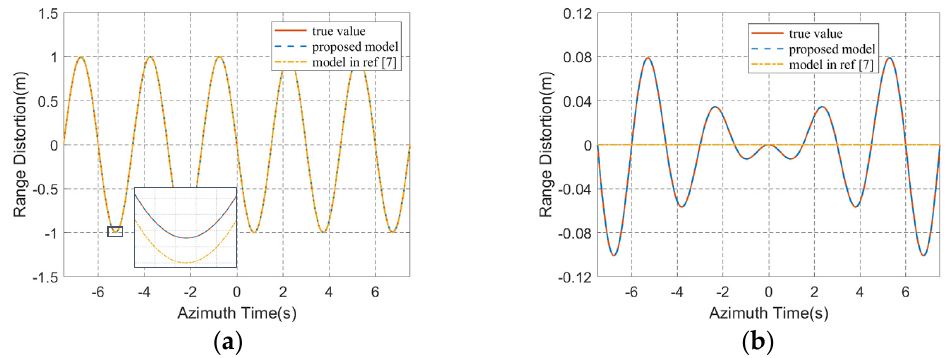
Figure 4. The range distortions introduced by target linear oscillation. ( a ) Oscillating along the range direction; ( b ) oscillating along the azimuth direction. Red solid lines represent the true values of the range distortions obtained by numerical calculation. Blue dotted lines are the results obtained by proposed model, which are basically coincide with the red lines. Yellow dot-dash lines are the results obtained by the model in reference [7].